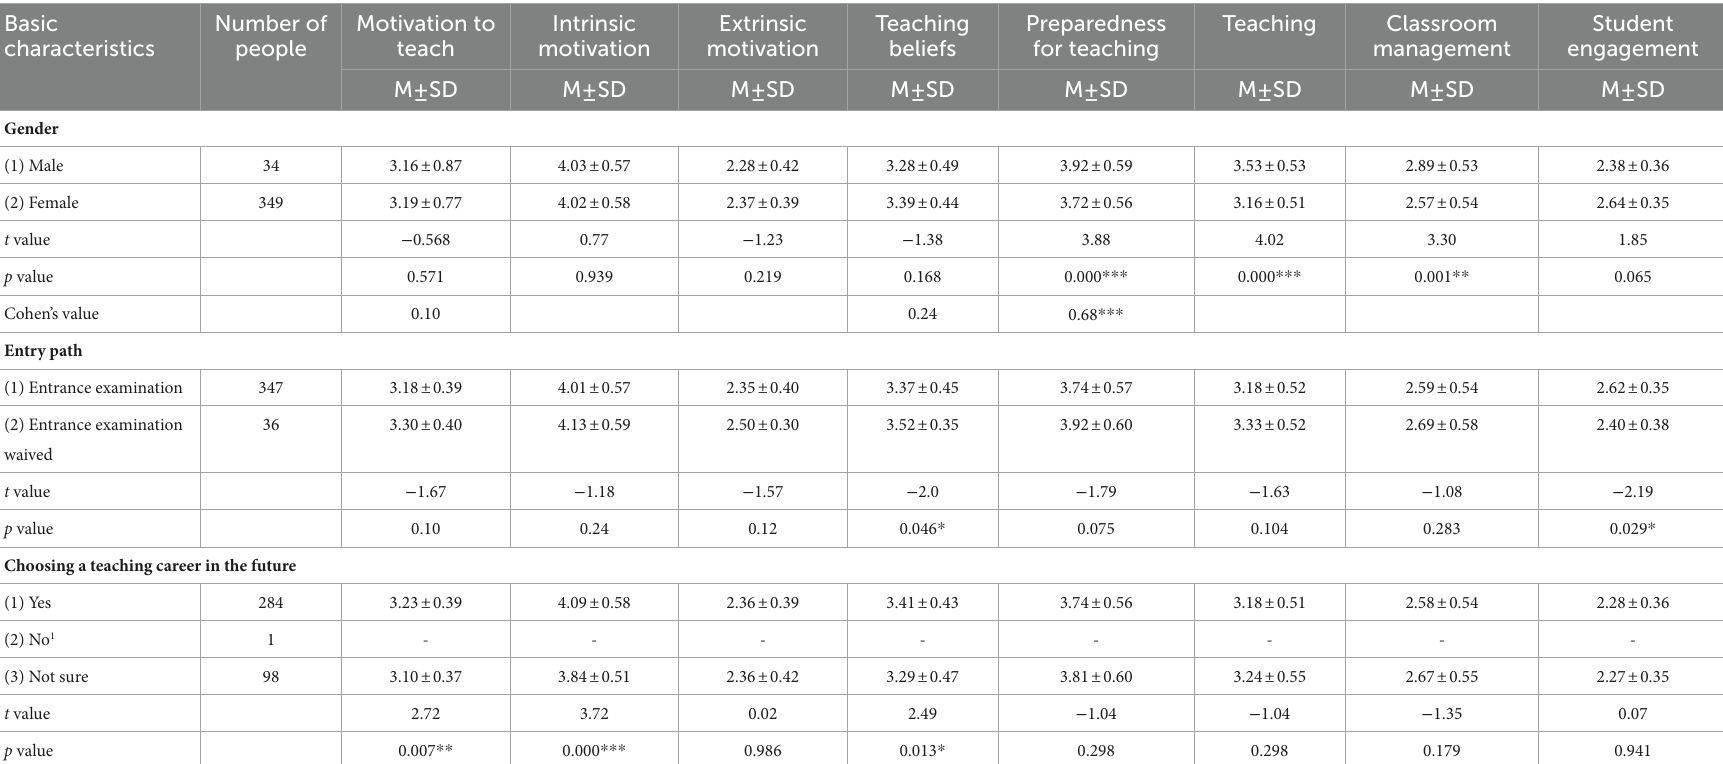
TABLE 1 Demographic characteristics of preservice teachers and score differences for various variables. Basic